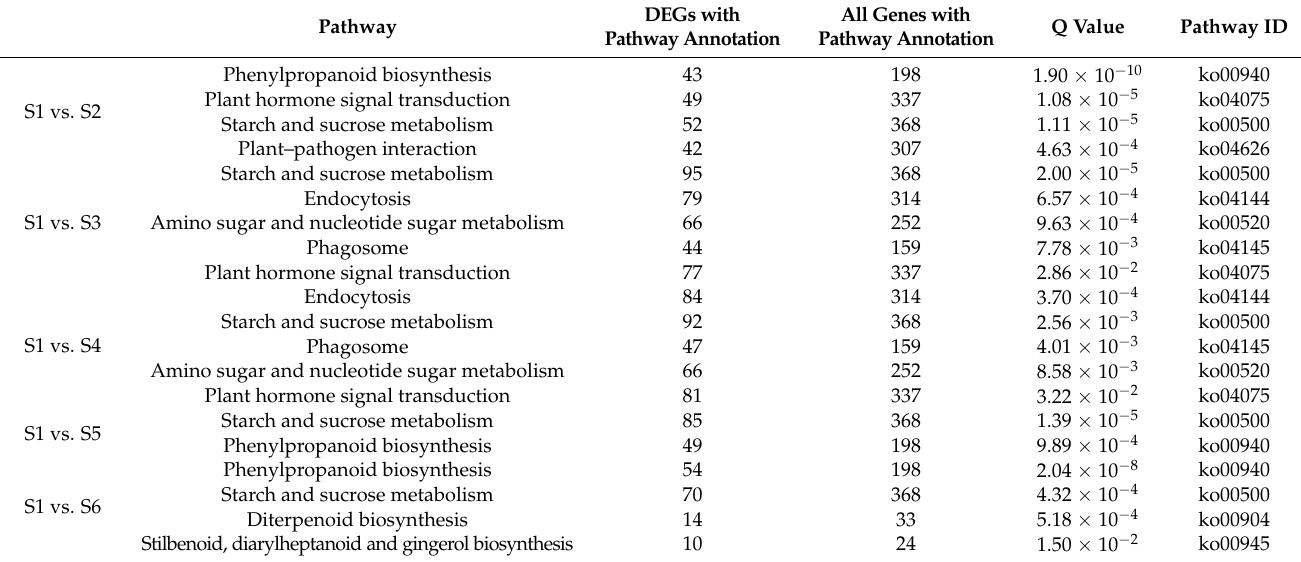
Table 4. KEGG enrichment analysis of the DEGs from the hybrid poplar xylem. Pathway